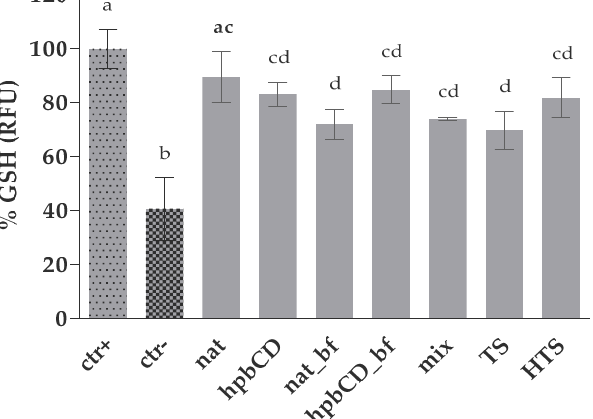
Figure 3. Protective effect of OPEs and pure polyphenols against oxidative stress on HepG2 GSH content. Data are presented as mean ± standard deviation ( n = 3) of the relative fluorescence units (RFU) calculated according to Equation (2); Positive control cells (ctr+) were treated with PBS while negative control cells (ctr − ) were treated with tBOOH. All the other cells were treated both with samples and tBOOH. The final concentrations of the samples in wells are noted in Table 1. Different letters (a, b, c, d) indicate statistically significant differences compared to ctr+ ( p < 0.05). Native olive pomace extract (nat), olive pomace extract with hydroxypropyl β -cyclodextrin (hpbCD); bioaccessible fraction (bf), tyrosol (TS), hydroxytyrosol (HTS), TS and HTS in the same concentration as in native sample (mix).